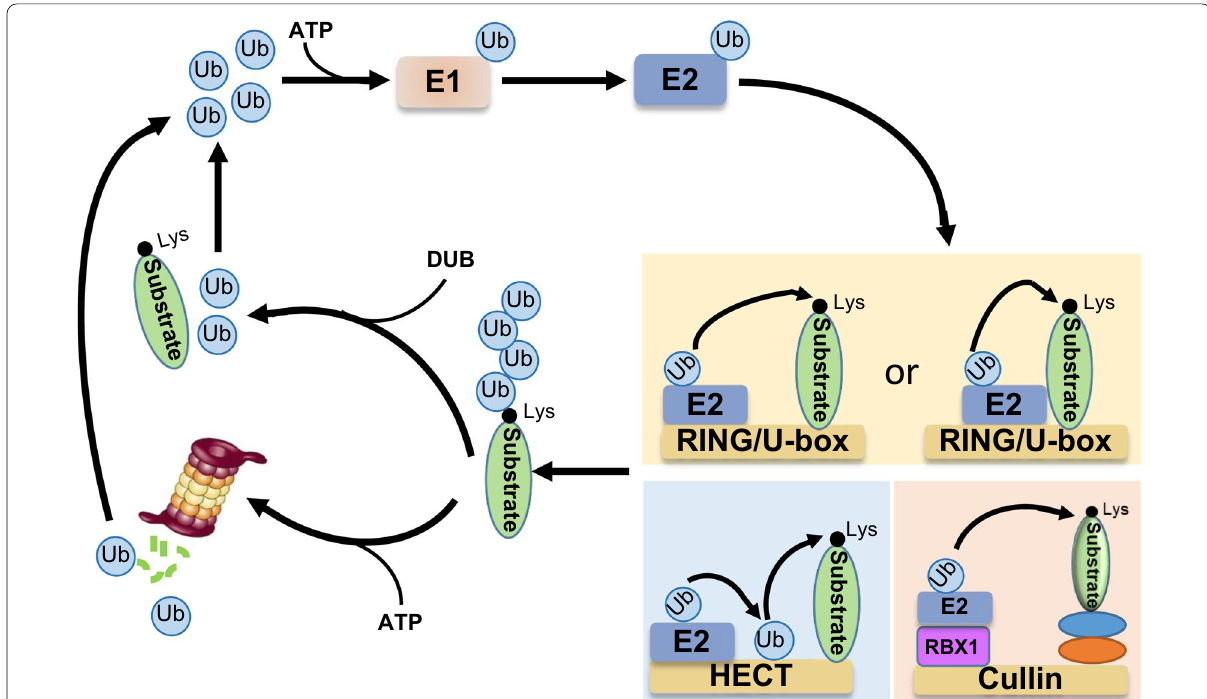
Fig. 1 Schematic diagram depicting the process of the ubiquitin–proteasome system. First, ubiquitin is activated by E1 with the energy provided by ATP. Subsequently, the activated ubiquitin is transferred to an active cysteine of E2. And then, E3 catalyzes the transfer of ubiquitin from E2 to the substrate with the formation of an isopeptide bond between the carboxy‑terminal glycine of ubiquitin and a lysine residue of the target protein. In the case of RING/U‑box type E3 ligase, E2 interacts with or does not interact with substrate; whereas in the case of HECT type E3 ligase, ubiquitin is directly transferred to a lysine residue in a substrate protein by E3s. Finally, the ubiquitinated substrate is degraded by the 26S proteasome and ubiquitins are released. Ubiquitins linked to the substrates could also be removed by DUB before the degradation. E1, ubiquitin‑activating enzyme; E2, ubiquitin‑conjugating enzyme; E3, ubiquitin ligase; DUB, deubiquitinating